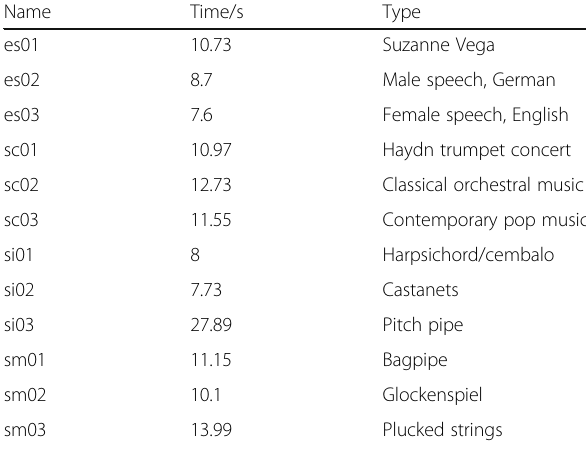
Table 2 The description of the 12 MPEG mono sequences